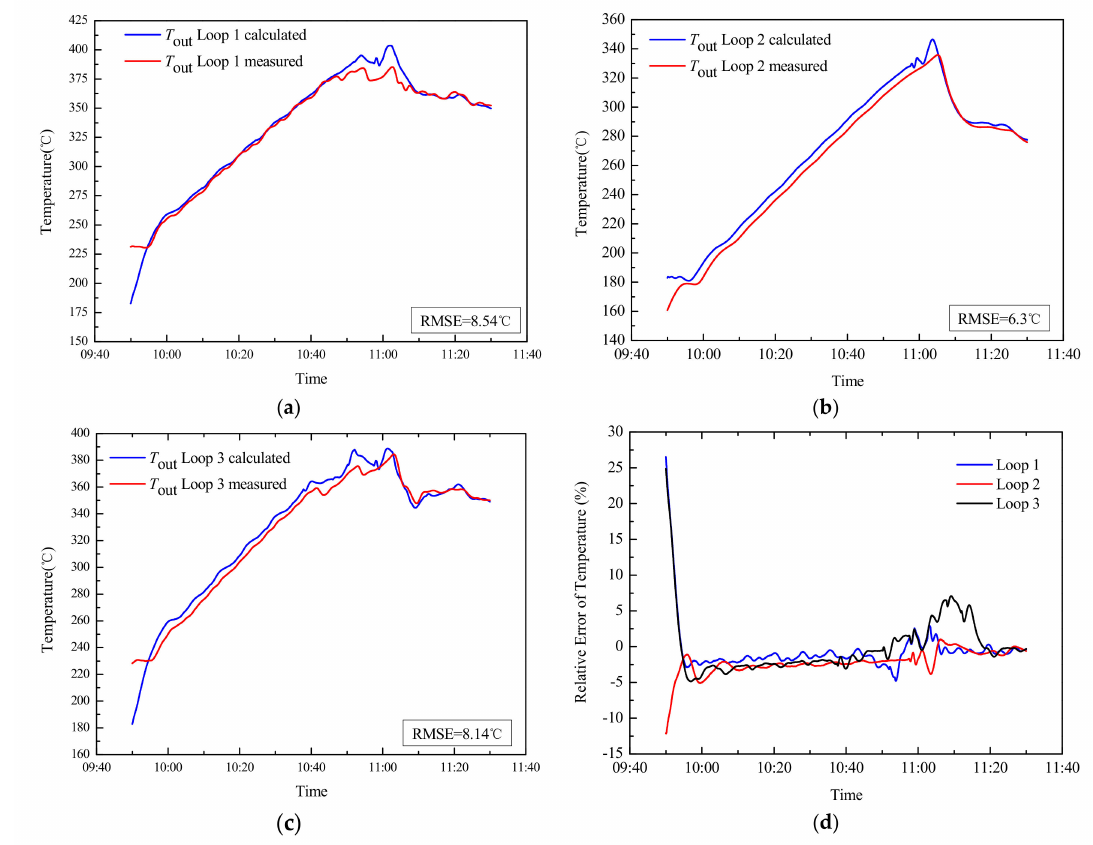
Figure 15. Compared results between calculated and measured data in hot test for ( a – c ): the outlet temperature of loops 1 to 3; and ( d ) the relative temperature